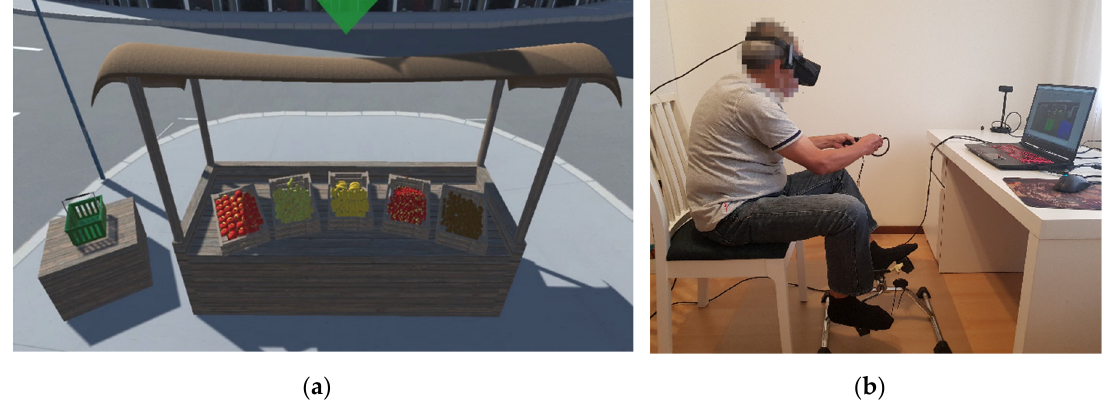
Figure 1. ( a ) Example of a task in the virtual city; ( b ) Example of using the application.